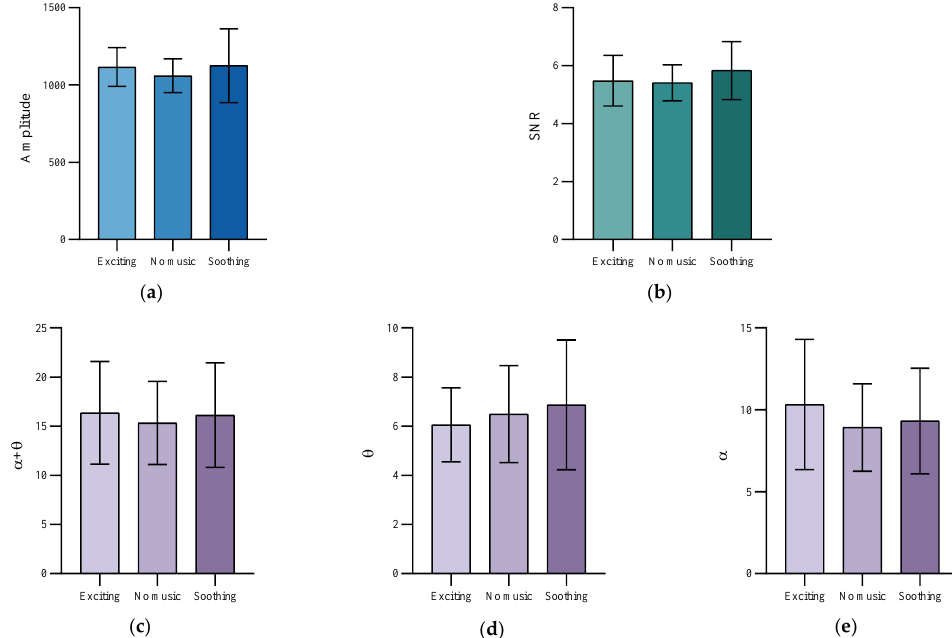
Figure 4. Comparison of the indicators in fatigue stage 1 under different background music modes. ( a ) Amplitude. ( b ) SNR. ( c ) α + θ band index. ( d ) θ band. ( e ) α band.